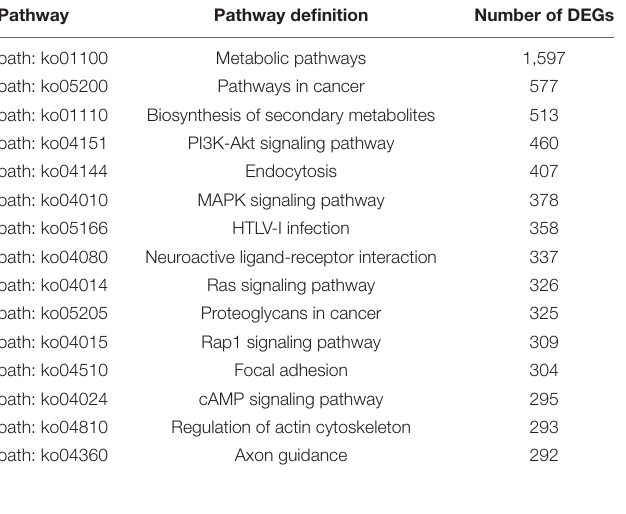
TABLE 6 | KEGG pathway annotation of DEGs (top 15).